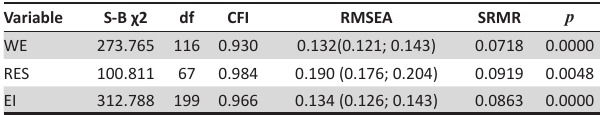
TABLE 2: Goodness of fit statistics.